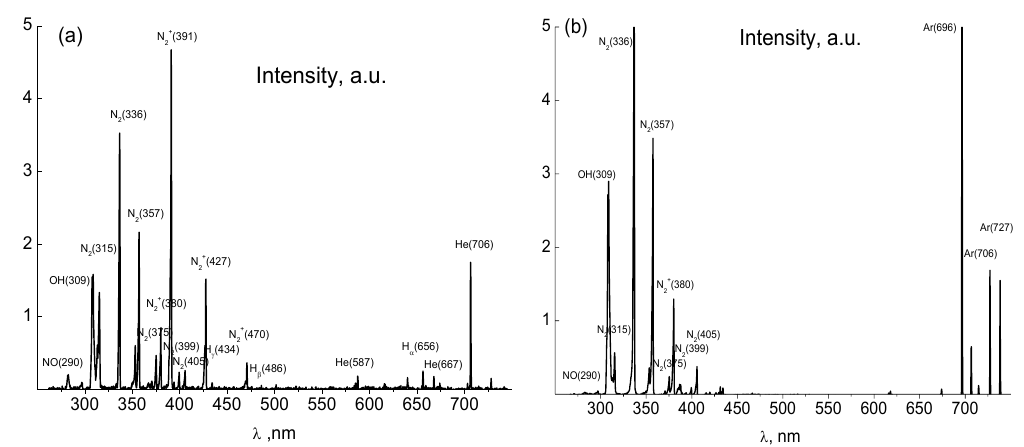
Figure 4. CAP spectra ( a ) in helium, v = 9.4 L/min, U = 5 kV, and ( b ) in argon, v = 3 L/min, U = 6.3 kV.